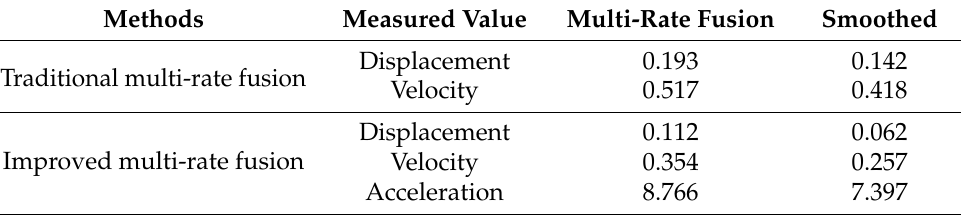
Table 1. Root mean square error (RMSE) of improved multi-rate Kalman fusion and smoothing